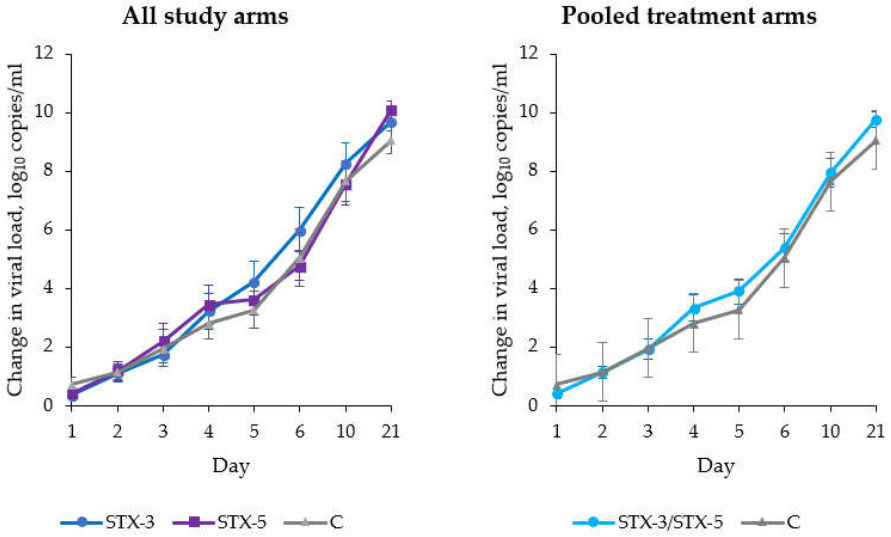
Figure 2. Absolute change in viral loads in the intention-to-treat (ITT) population ( n = 54), by study arm and day of follow-up (vertical bars represent standard errors).